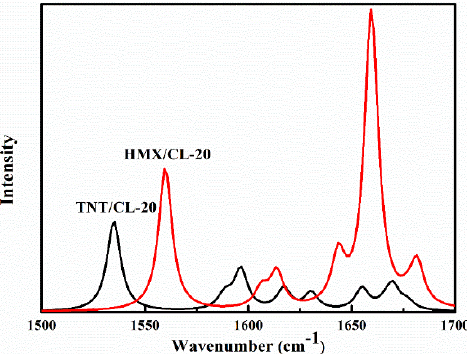
Figure 2. The theoretical infrared spectra of NO 2 asymmetric stretching in TNT/CL-20 and HMX/CL- 20.